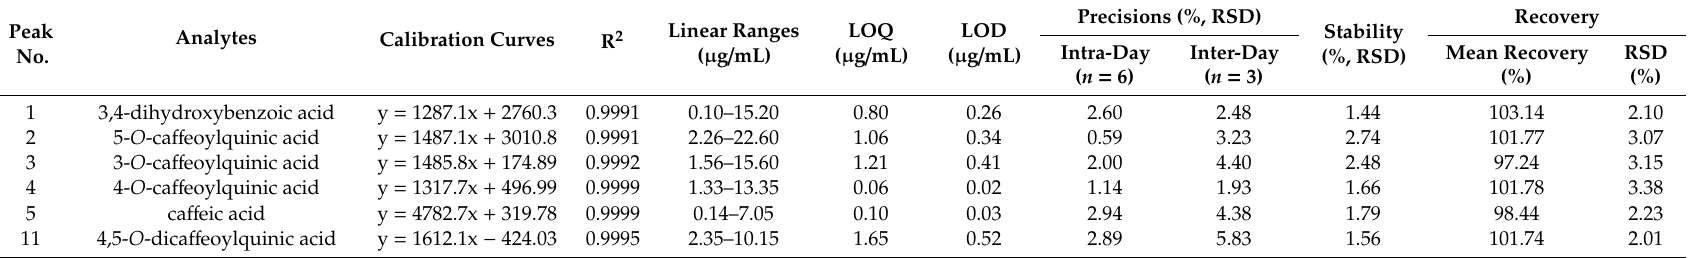
Table 3. Regression equations, linearity ranges, correlation coe ffi cients, LOQ, LOD, and inter-day and intra-day precisions and stability for six analytes using the PDA